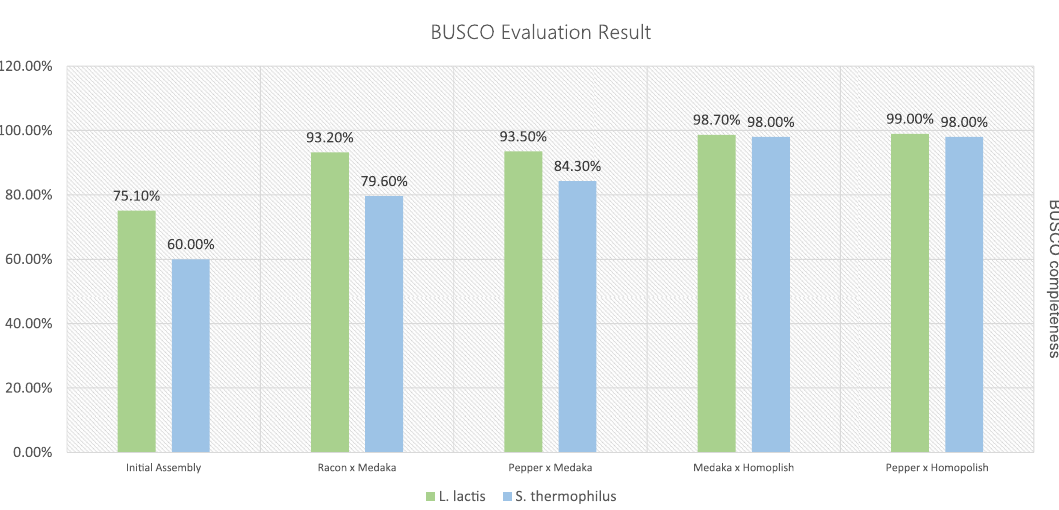
Figure 7. BUSCO evaluation result using enterobacterales_odb10 for two probiotic